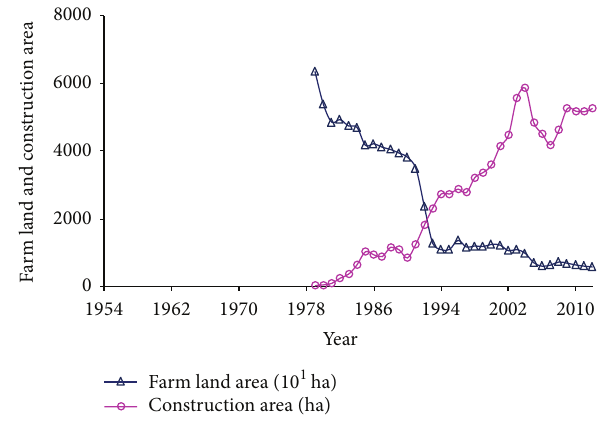
Figure 13: Temporal trend of the farmland area and the floor space of the buildings under